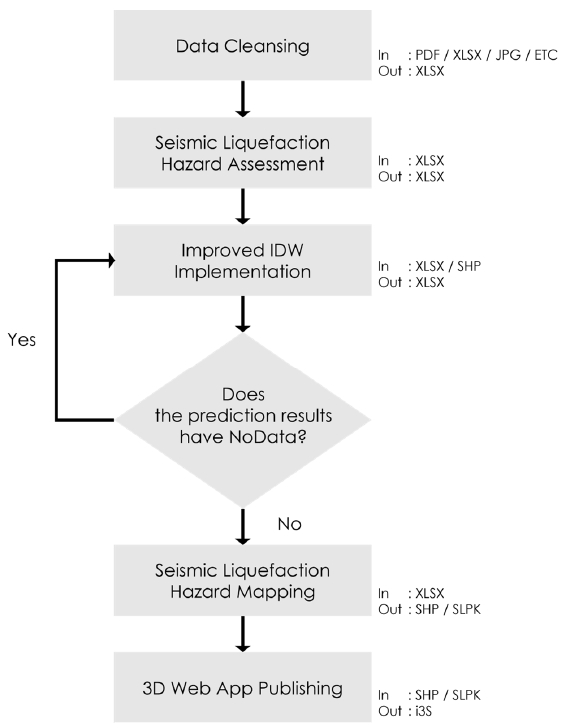
Figure 5. Workflow of borehole data ‐ based seismic liquefaction hazard assessment and mapping .